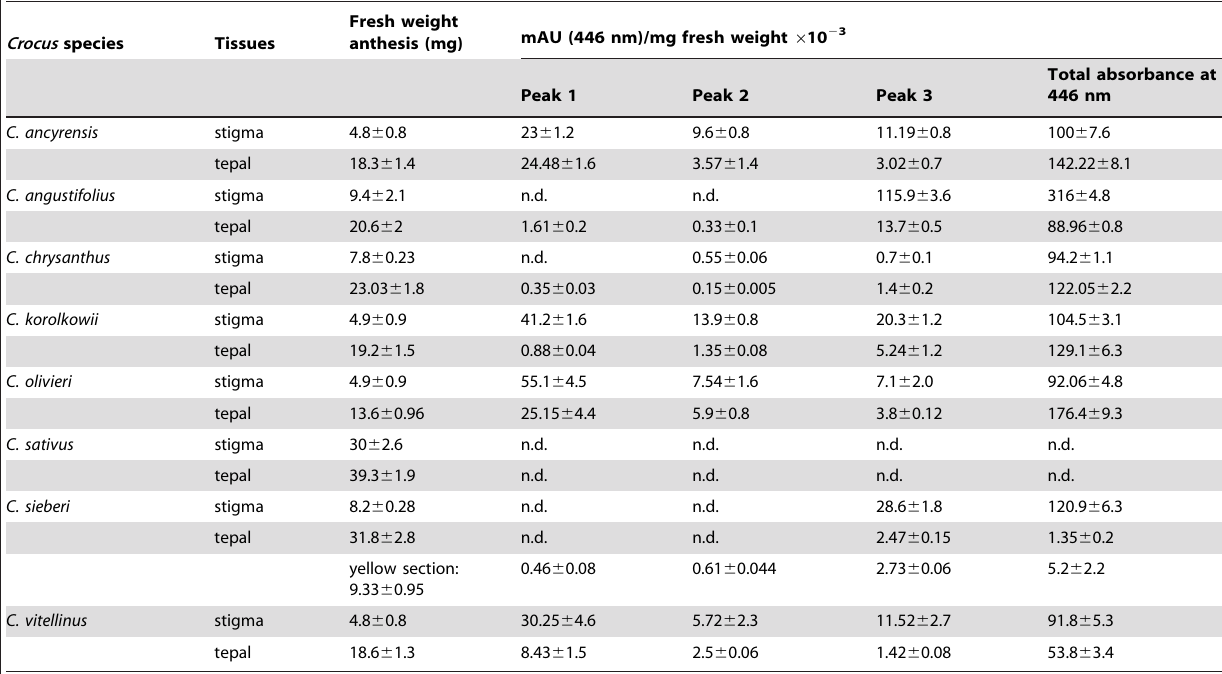
Table 2. Levels of highly glucosylated crocins in stigmas and tepals of different Crocus species at anthesis.